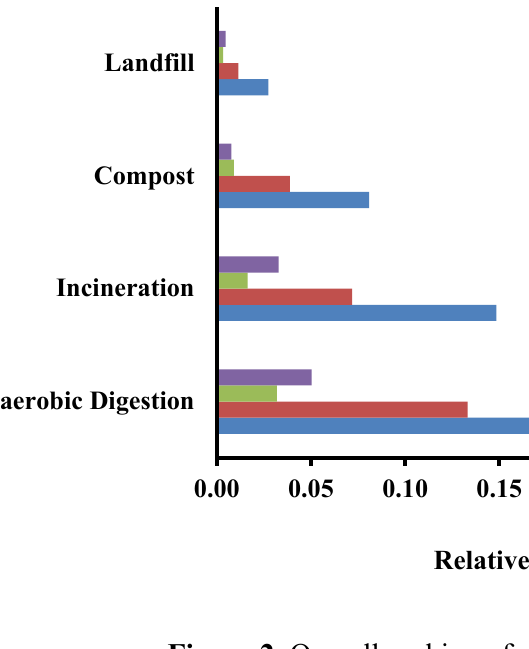
Figure 2. Overall ranking of all